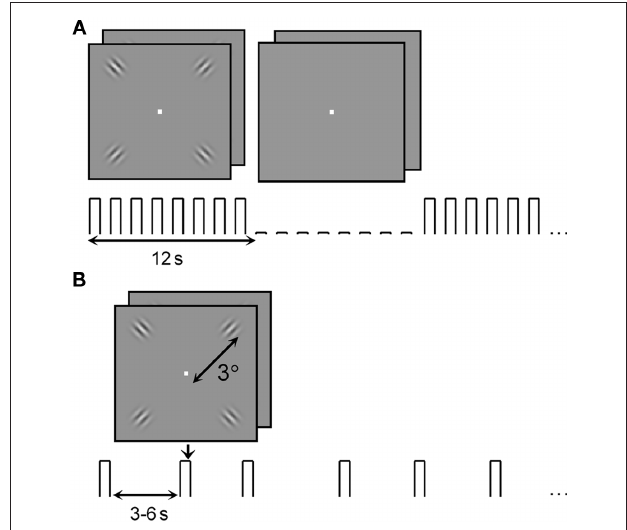
FIguRe 1 | Stimuli used to study the BOLD fMRI contrast response in V1. (A) Block-design localizer scans were used to select regions of interest for analysis of the event-related data. (B) Stimuli for event-related scans were presented in a 2IFC paradigm at 5, 10, 30, and 90% contrast with inter-trial intervals randomly distributed between 3 and